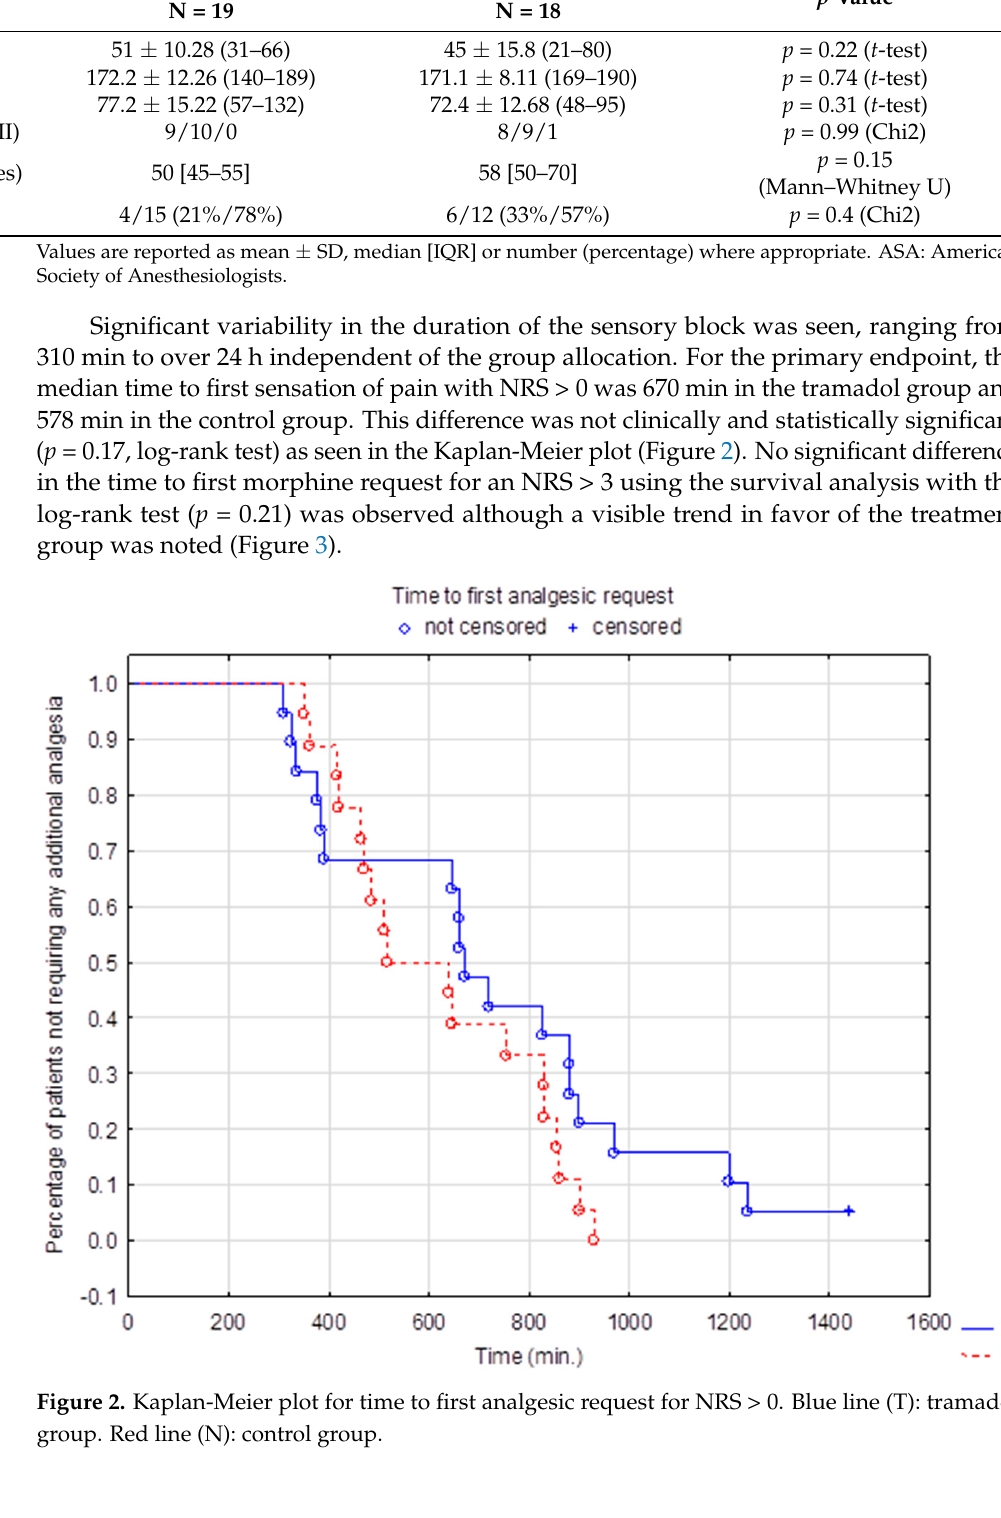
Table 1. Basic demographic characteristics.